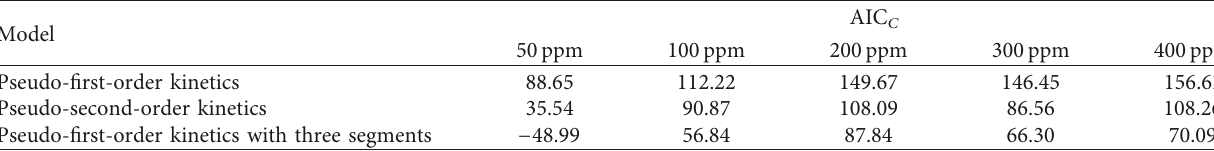
Table 6: AIC C values of the different kinetic